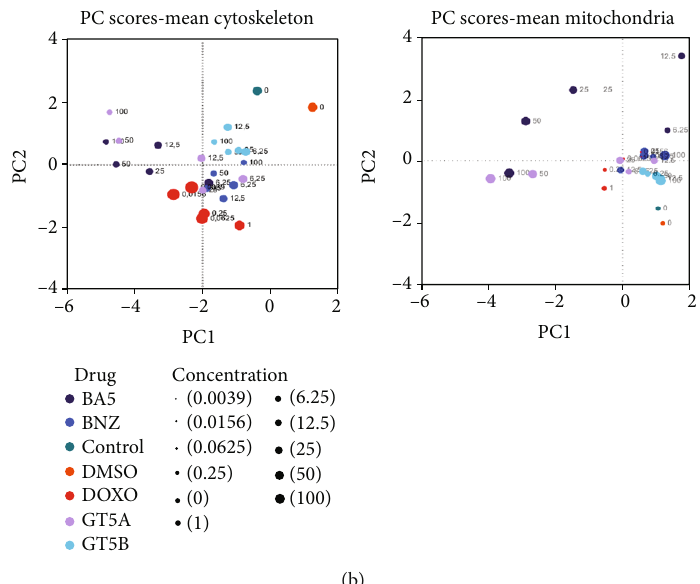
Figure 4: High-content imaging analysis of sublethal cardiotoxicity of anti- T. cruzi compounds. (a) Representative images of hiPSC-CMs untreated (control) or treated with 0.5% DMSO, 1 μ M doxorubicin (Doxo), benznidazole (BNZ), BA5, GT5A, or GT5B, all at the 25 μ M concentration. Cytoskeleton was stained with phalloidin (green) and mitochondria with MitoTracker (orange), and nuclei were stained with DAPI (blue). Bars = 100 μ m . (b) Principal component analysis demonstrating the e ff ects of the compounds in di ff erent concentrations to the cytoskeleton and mitochondria scores.